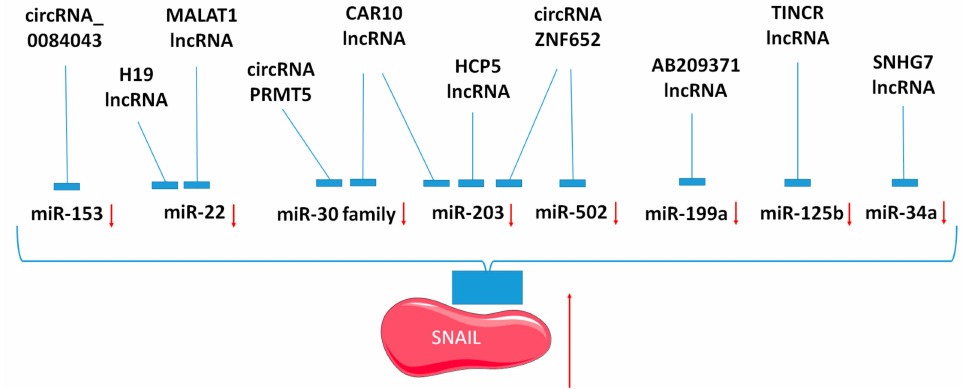
Figure 3. Role of long non-coding RNAs and circular RNAs as sponges for microRNAs in the regulation of SNAIL expression in